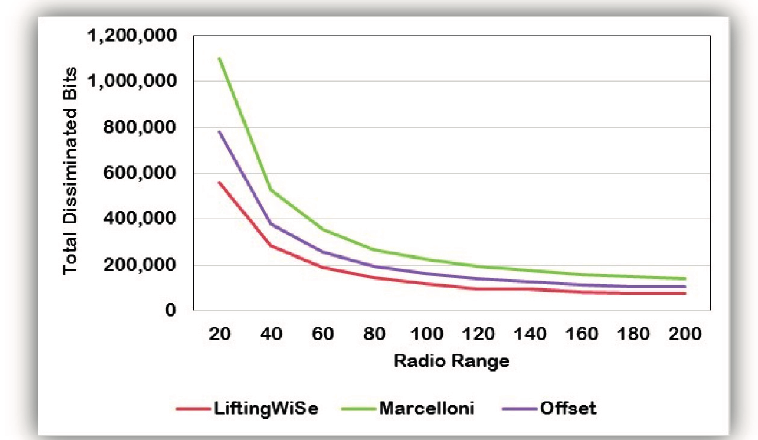
Figure 11. The effect of the radio range on the number of disseminated